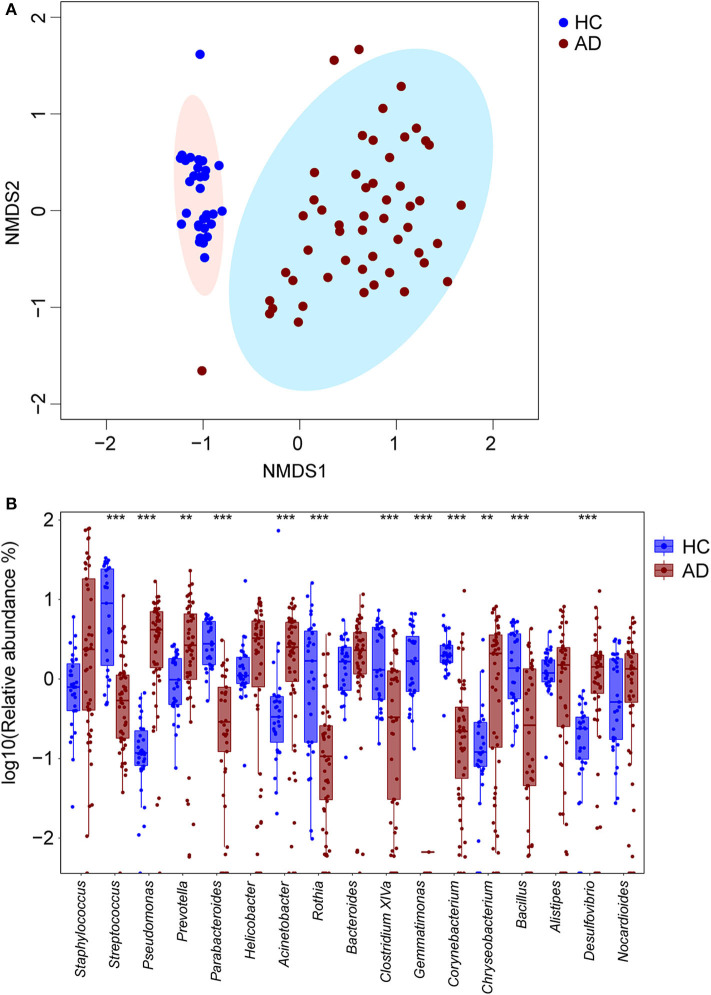
Differing cutaneous microbiota at baseline in HC and AD patients. (A) Non-metric multi-dimensional scaling (NMDS) plot of bacteria in cutaneous samples from 31 HC (blue circles) and 51 children with AD (maroon circles). By NMDS analysis, these two groups are distinct. (B) The 10 most abundant genera for 31 HC and 51 AD patients were detected, and their log10 relative abundances represented with blue and maroon boxes respectively. In each box, the median value suggested the baseline abundances of the genera in the group. Differentially enriched microbial constituents between these two groups were suggested with **P < 0.01 and ***P < 0.001.